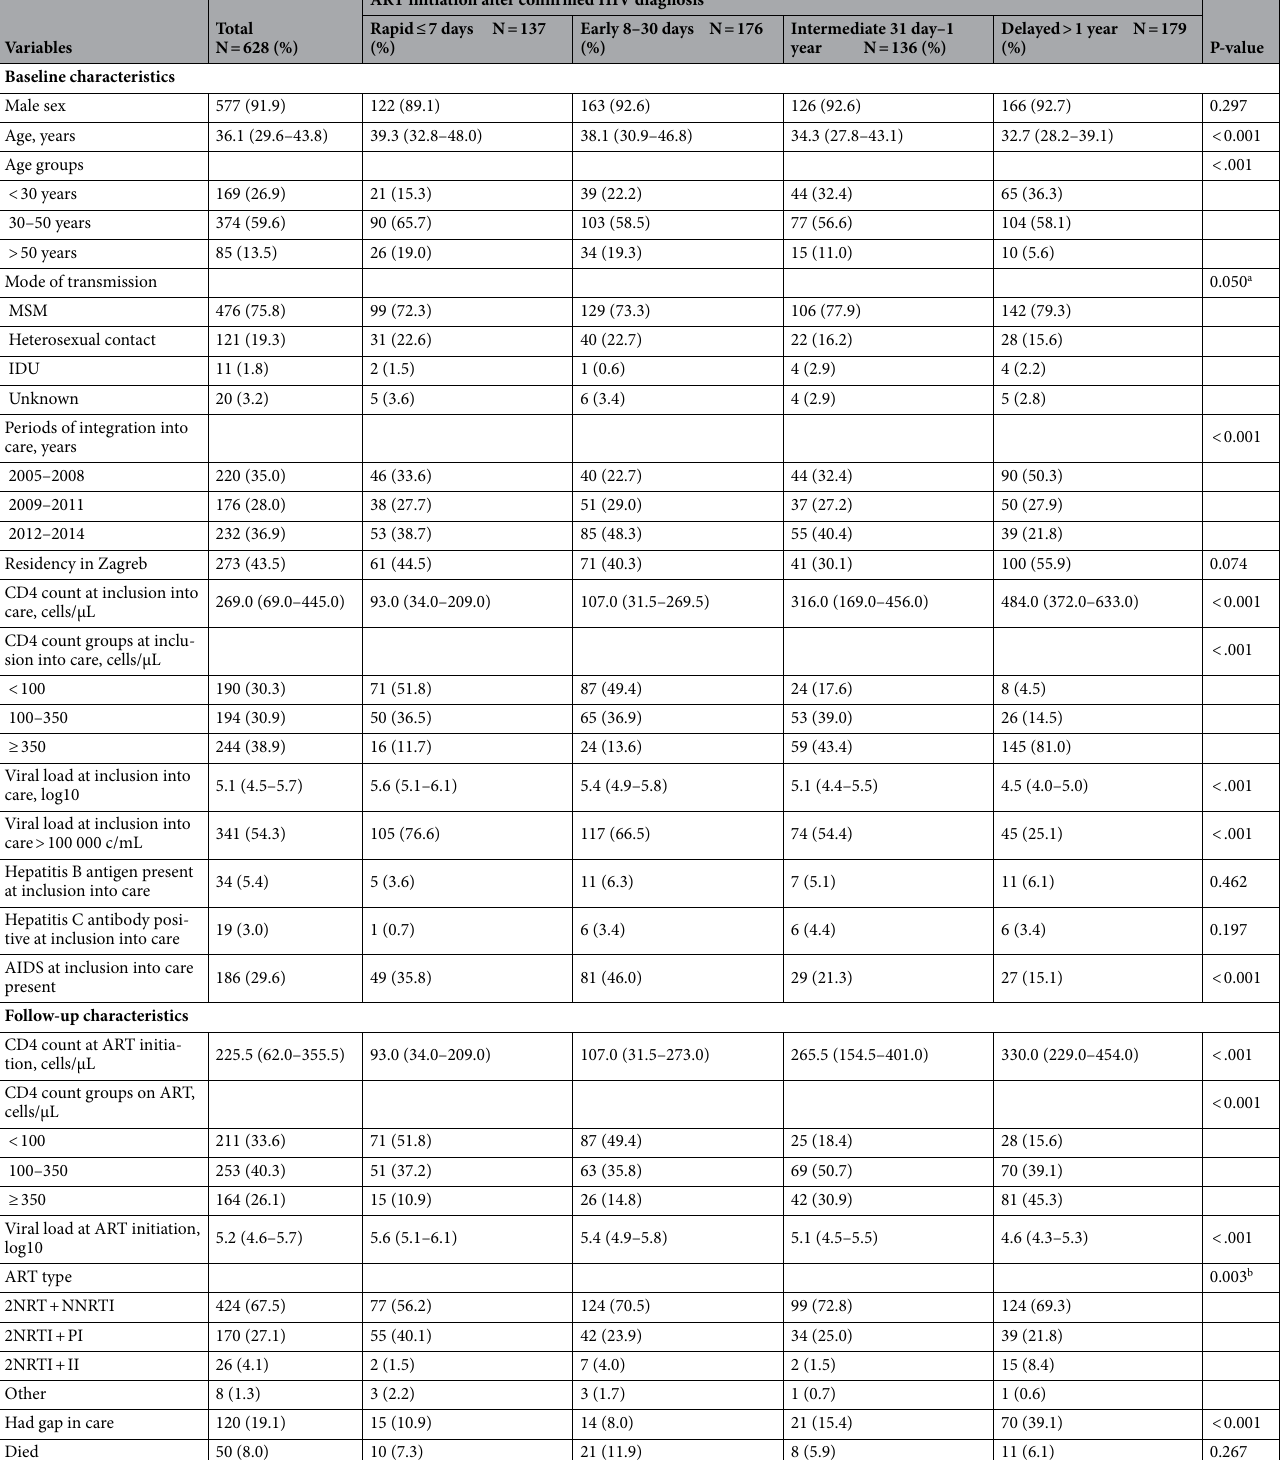
Table 1. Main characteristics of the entire study cohort and of each group based on antiretroviral therapy initiation after confirmed HIV diagnosis. Values are frequencies, percentages and median with first and third quartiles (Q1, Q3). MSM men who have sex with men; IDU injecting drug use; ART antiretroviral therapy; NRTI nucleoside analogues reverse transcriptase inhibitors; NNRTI nonnucleoside reverse transcriptase inhibitors; PI protease inhibitors, II integrase inhibitors. a Cohrane-Armitage trend test for comparison of MSM versus heterosexual mode of transmission. b Cohrane-Armitage trend test for the comparison of 2NRTI + NNRTI versus 2NRTI +